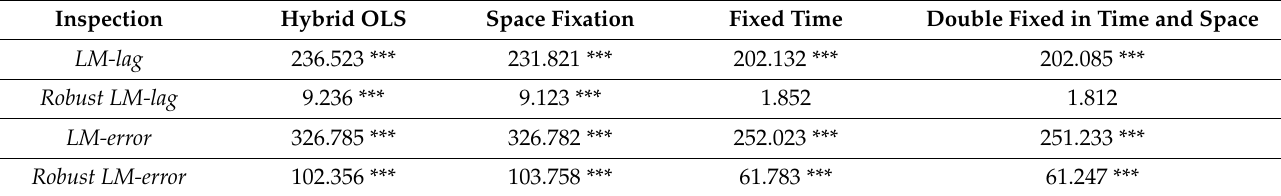
Table 3. LM test for the ordinary panel